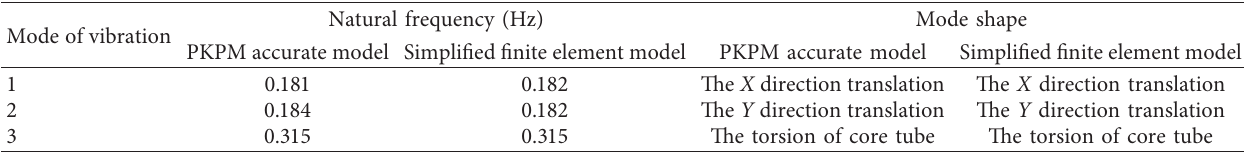
Table 7: The first three natural frequencies of the core